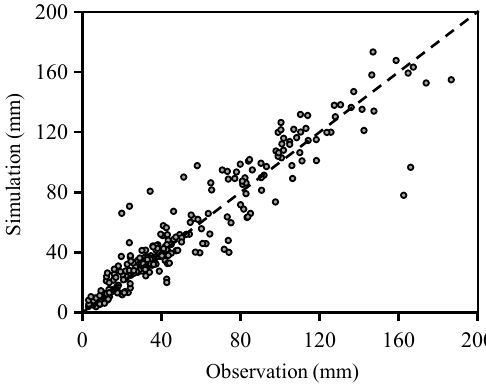
Figure 5. Scatter plot for the observation and simulation results of the monthly runoff and groundwater discharge in the study catch- ments in the calibration